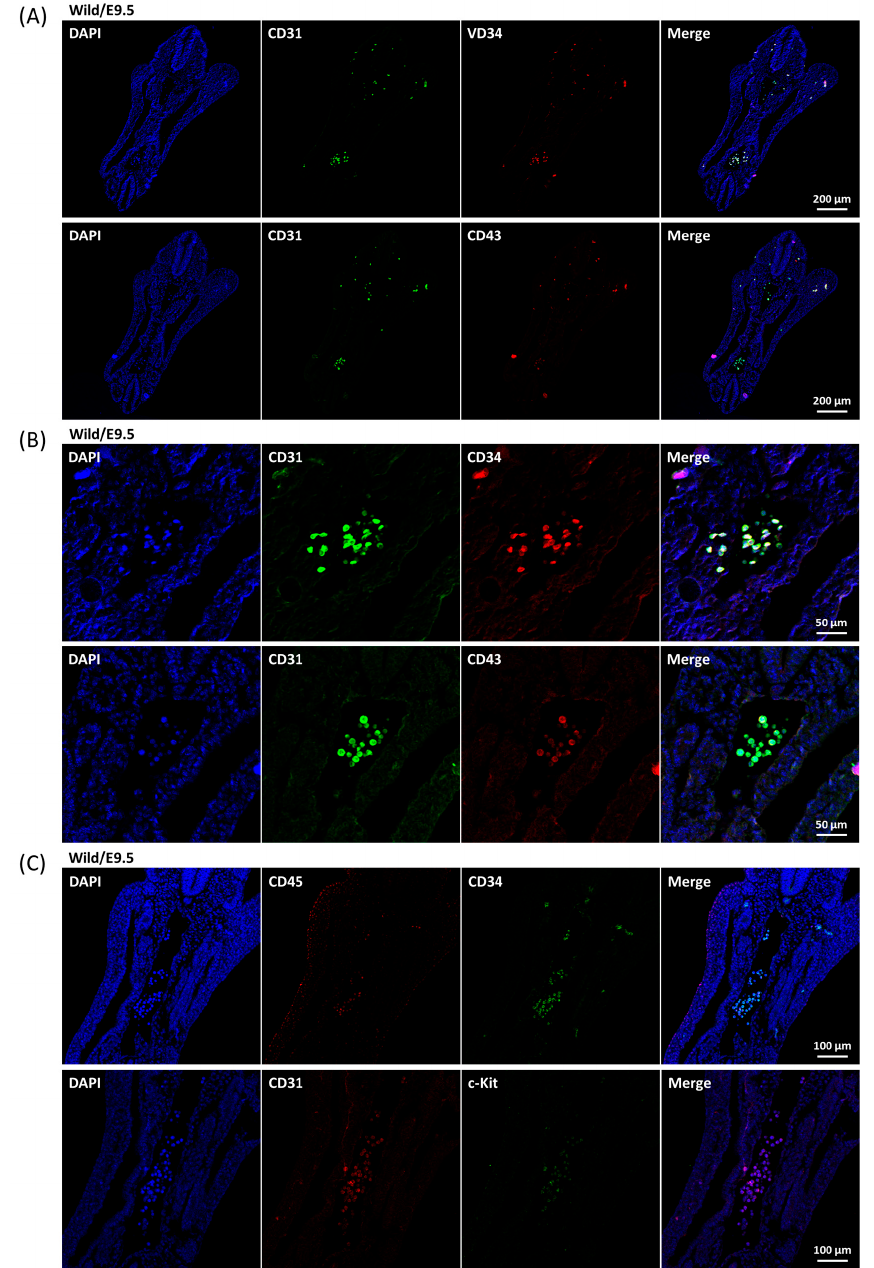
Figure 4. Expression patterns of CD31, CD34, and HSC markers in E9.5 wild-type embryo. ( A ) Besides the SCL-C and SCL-N, the wild-type transverse E9.5 embryonic sections were prepared and co-incubated with either CD31 and CD34 (upper panels) or CD31 and CD43 (lower panels) anti-bodies. Only the dispersed cells were stained. ( B ) Image at higher magni fi cation focusing on the major groups of the dispersed cells. ( C ) The wild-type transverse E9.5 embryonic sections were